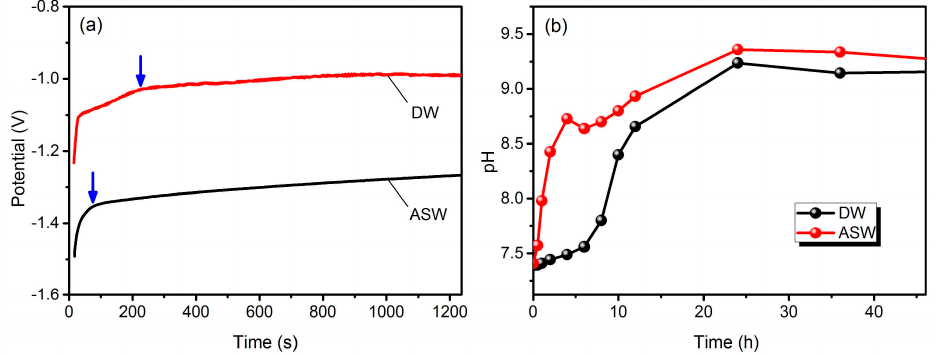
Figure 4. ( a ) The OCP (Open circuit potential) curves of MZC ribbon in ASW and DW solutions and ( b ) The pH value of the treated ASW and DW solution immersed in MZC ribbons for various times.